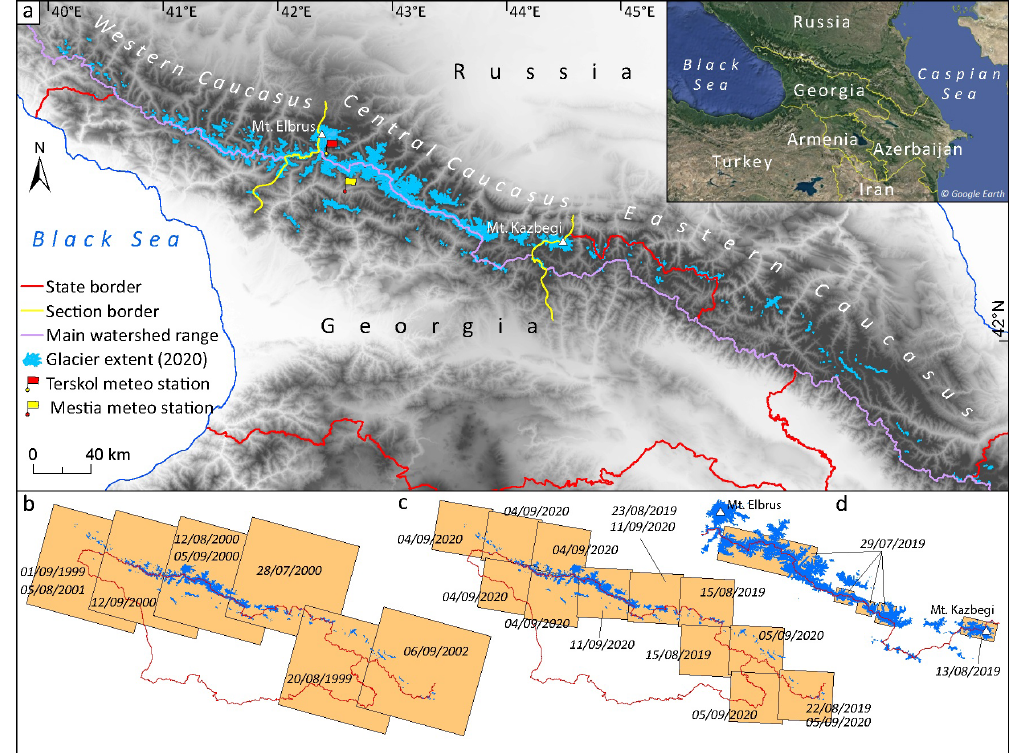
Figure 1. (a) The extent of modern glaciers in the Greater Caucasus. (b) Landsat 5 TM and Landsat 7 ETM + satellite scenes from 1999– 2002. (c) Sentinel-2 satellite scenes from 2019–2020. (d) SPOT 6/7 satellite scenes from 2019. The insert map in the upper right shows the location of the Caucasus region (© Google